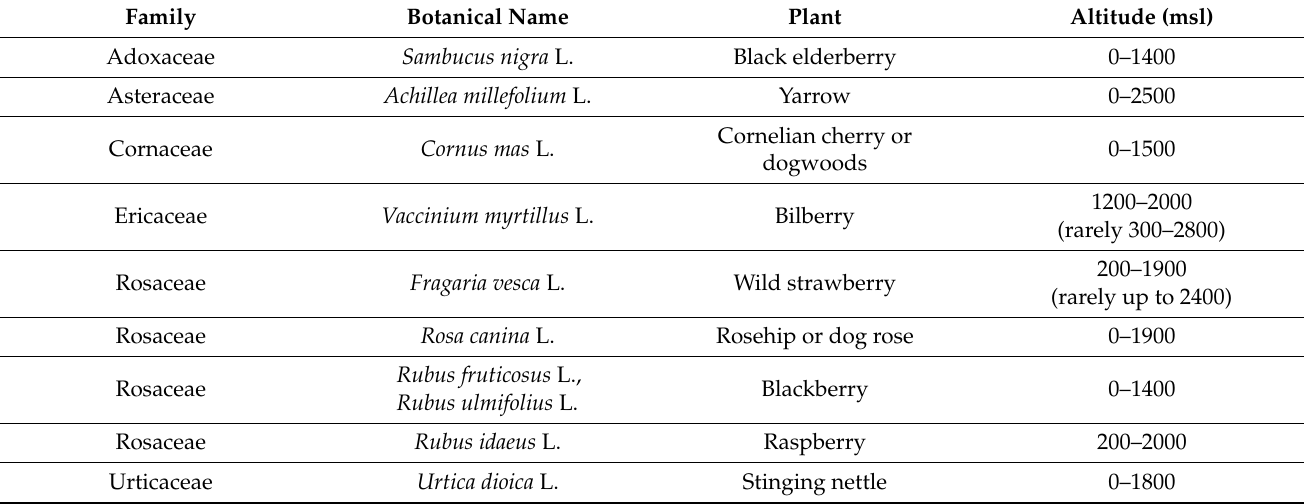
Table 1. Plants used in the Occitan valleys of the Piedmont Alps for which anti-diabetic properties have been suggested by the scientific literature published between